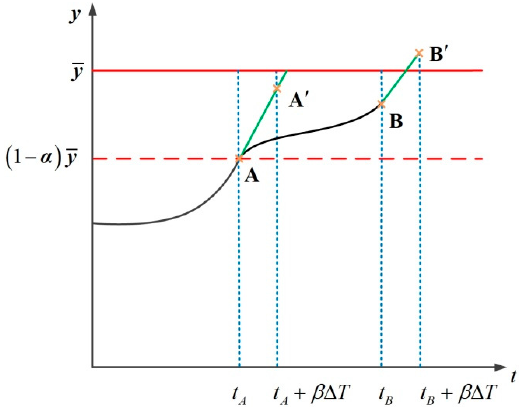
Figure 4. Upper-limited output switching logic diagram.